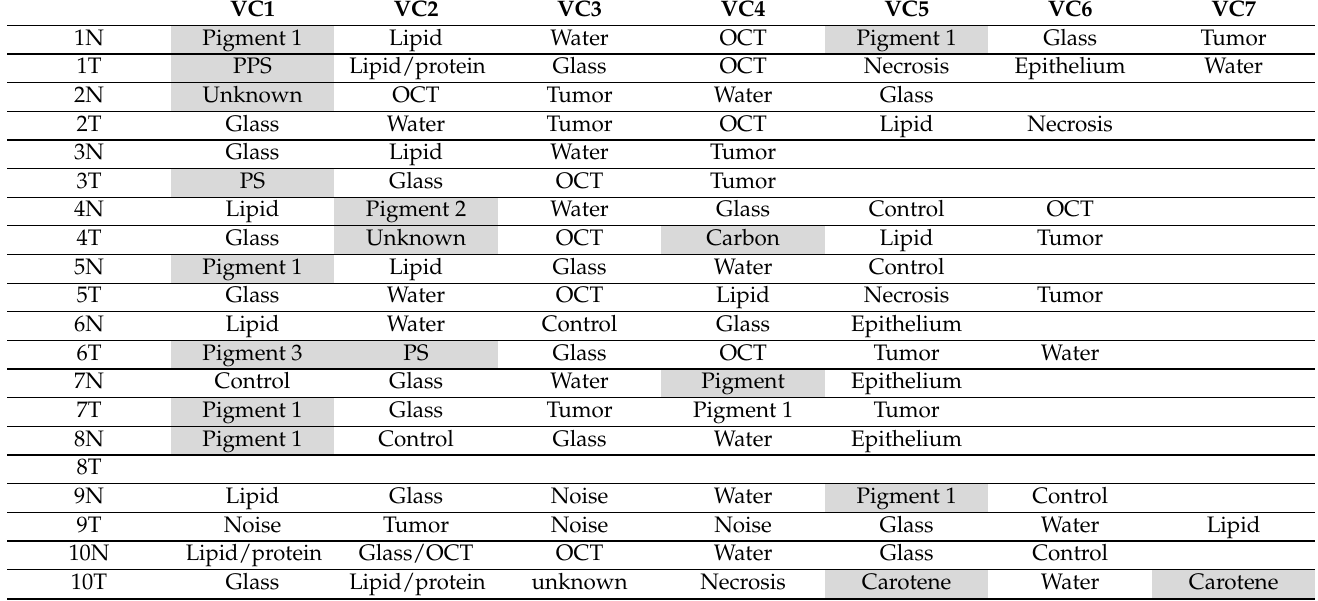
Table 1. Tentative assignment of tissue components obtained by VCA-based unmixing of Raman images from normal (N) and tumor (T) specimens